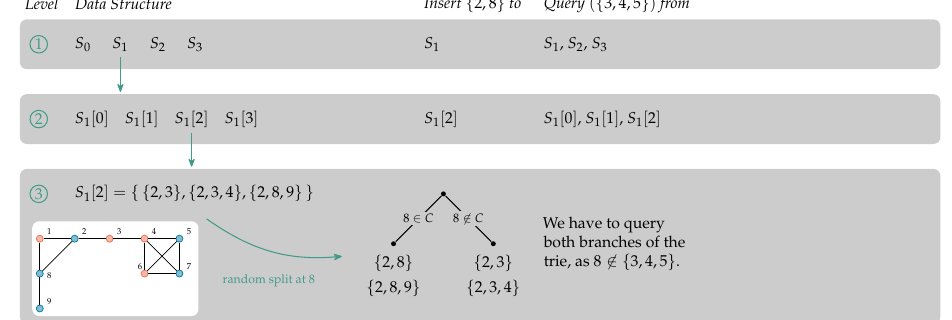
Figure 7. A color coding sieve for the nine vertex graph shown on the bottom left with k = 4 and γ = 1. The three levels are illustrated as gray boxes and show the contained sieves of the next level—green pointers indicate which level- i sieve is shown, i.e., the level-2 sieve is S 1 and the level-3 sieve is S 1 [ 2 ] (all the other sieves are not shown). In the center, an insert of first sieve inserts it to S 1 , the level-2 sieve S 1 inserts it to the level-3 sieve S 1 [ 2 ] (other branches are not shown). The level-2 sieve uses the random partition shown on the graph, that is, orange neighbors. The level-3 sieve S 1 [ 2 ] is an ordinary list before the insert and becomes a trie after the insert, as a random split at vertex 8 occurs. On the right side of the figure, we see all sieves that we have to search through in order to answer the query (